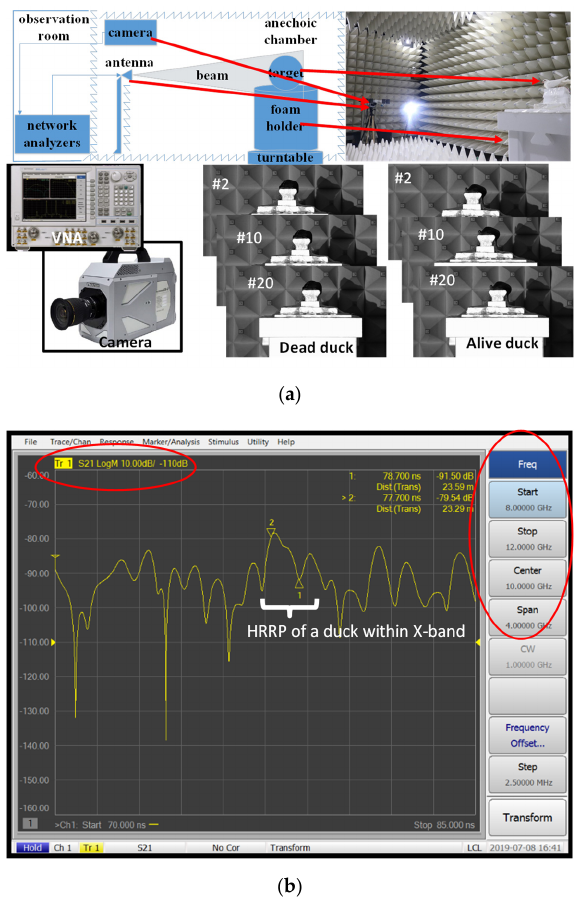
Figure 2. Tests in the anechoic chamber. ( a ) Photos of birds using the high-speed camera 1 , ( b ) a screenshot of the data measured by the Vector Network Analyzer, PNA-N5224A. 1 The number # x is the tracking ID.